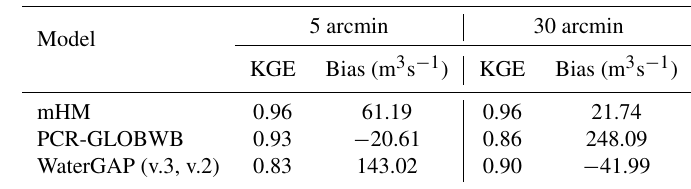
Table 2. Efficiency of mHM, PCR-GLOBWB (Ludovicus et al., 2017), and WaterGAP obtained for the Rhine Basin at the Lobith station during 2003 for spatial resolutions of 5 and